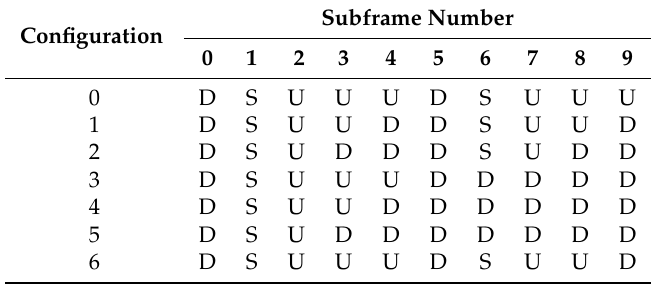
Table 3. TDD Frame Configurations (U: Uplink; D: Downlink) [29].